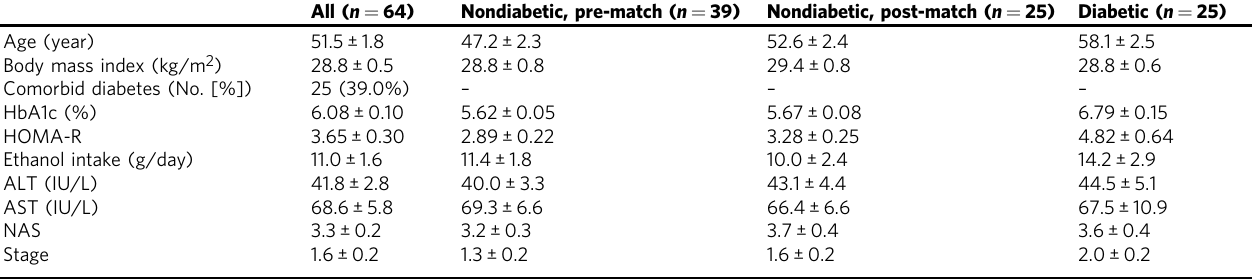
Table 1 Background characteristics of the human subjects